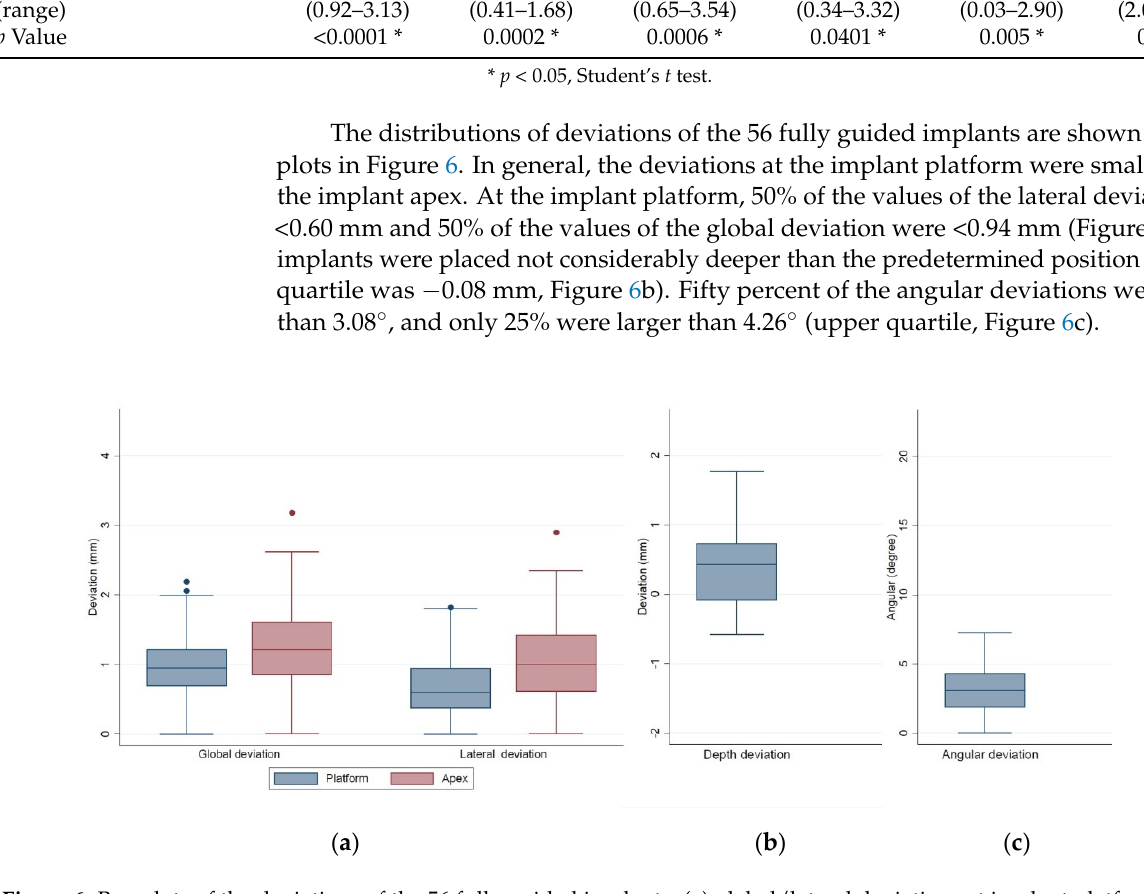
Figure 6. Box plots of the deviations of the 56 fully guided implants. ( a ) global/lateral deviations at implant platform and at implant apex, ( b ) depth deviation, and ( c ) angular deviation.